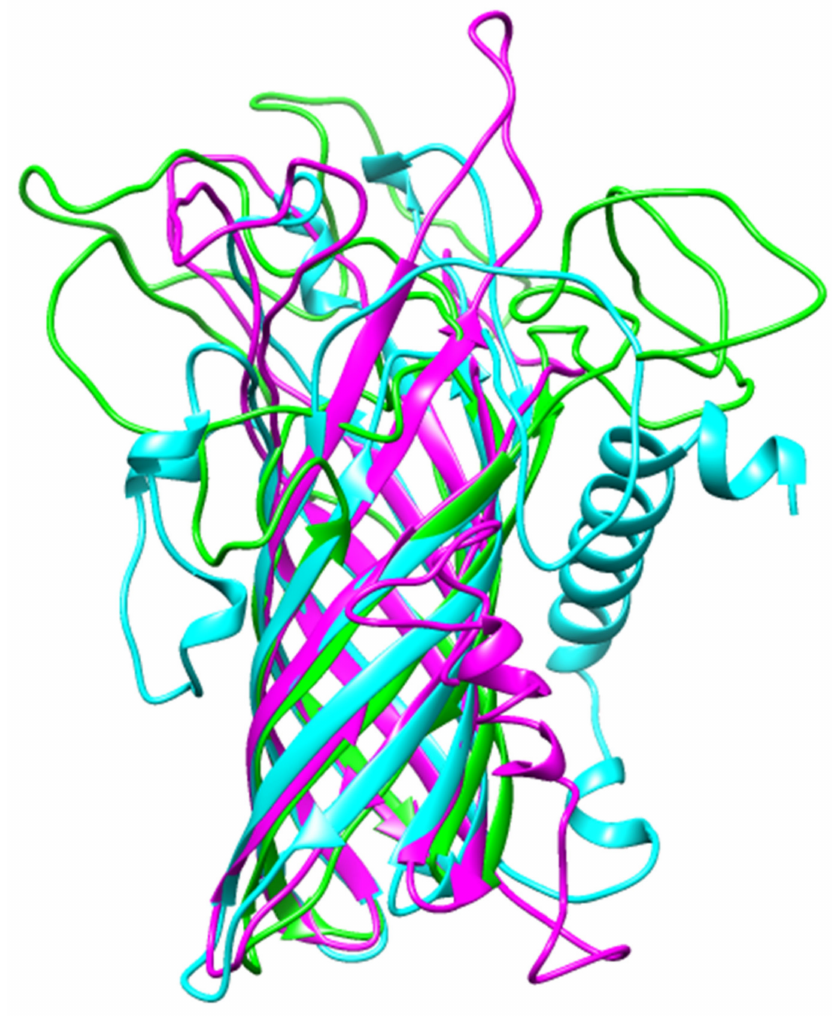
Figure 3. Alignment of the top three predicted tertiary structures of the Wolbachia surface protein from the 3 techniques using Chimera 1.12. ITAS1 is in magenta, ROB2 in cyan and MOD2 in